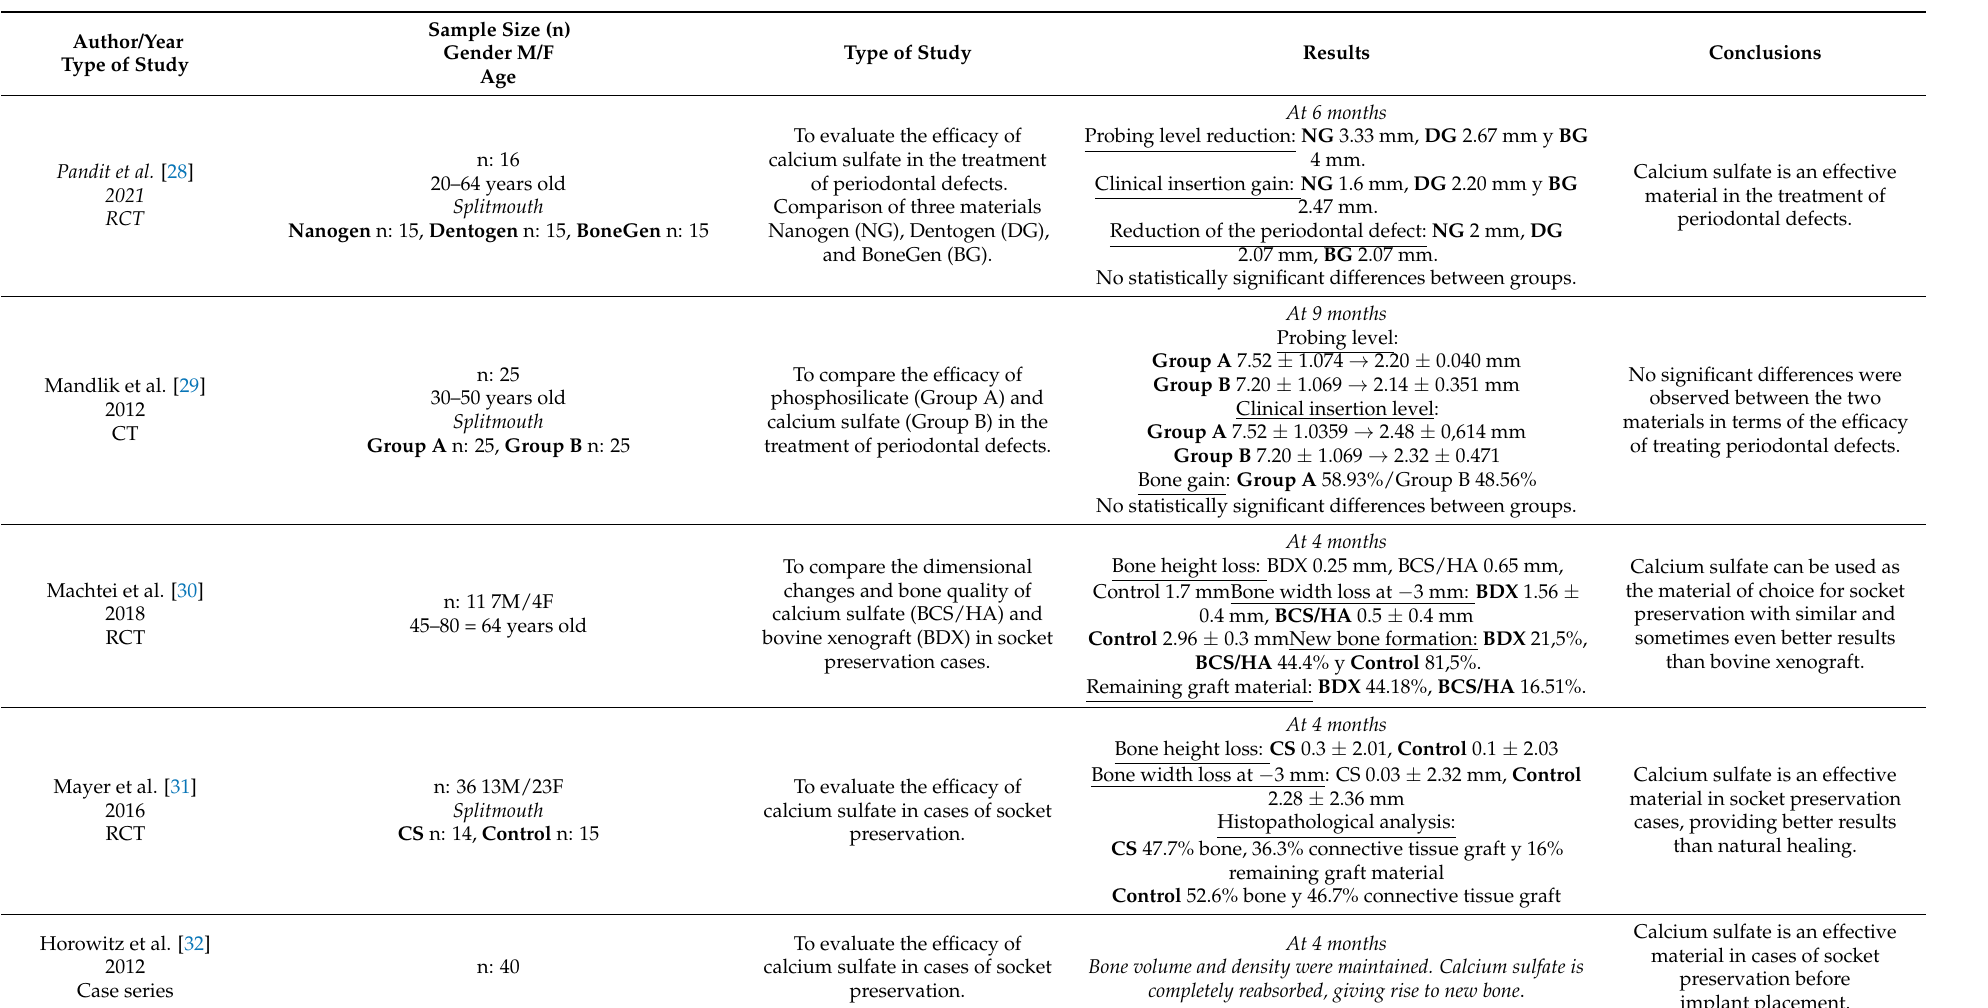
Table 1. Summary of the articles included. RCT: Randomized controlled clinical trial, CT: Controlled clinical trial, CS: Calcium sulfate, NG: Nanogen, DG: Dentogen, BG: BoneGen, BDX: Bovine Xenograft, BCS/HA: Calcium sulfate with